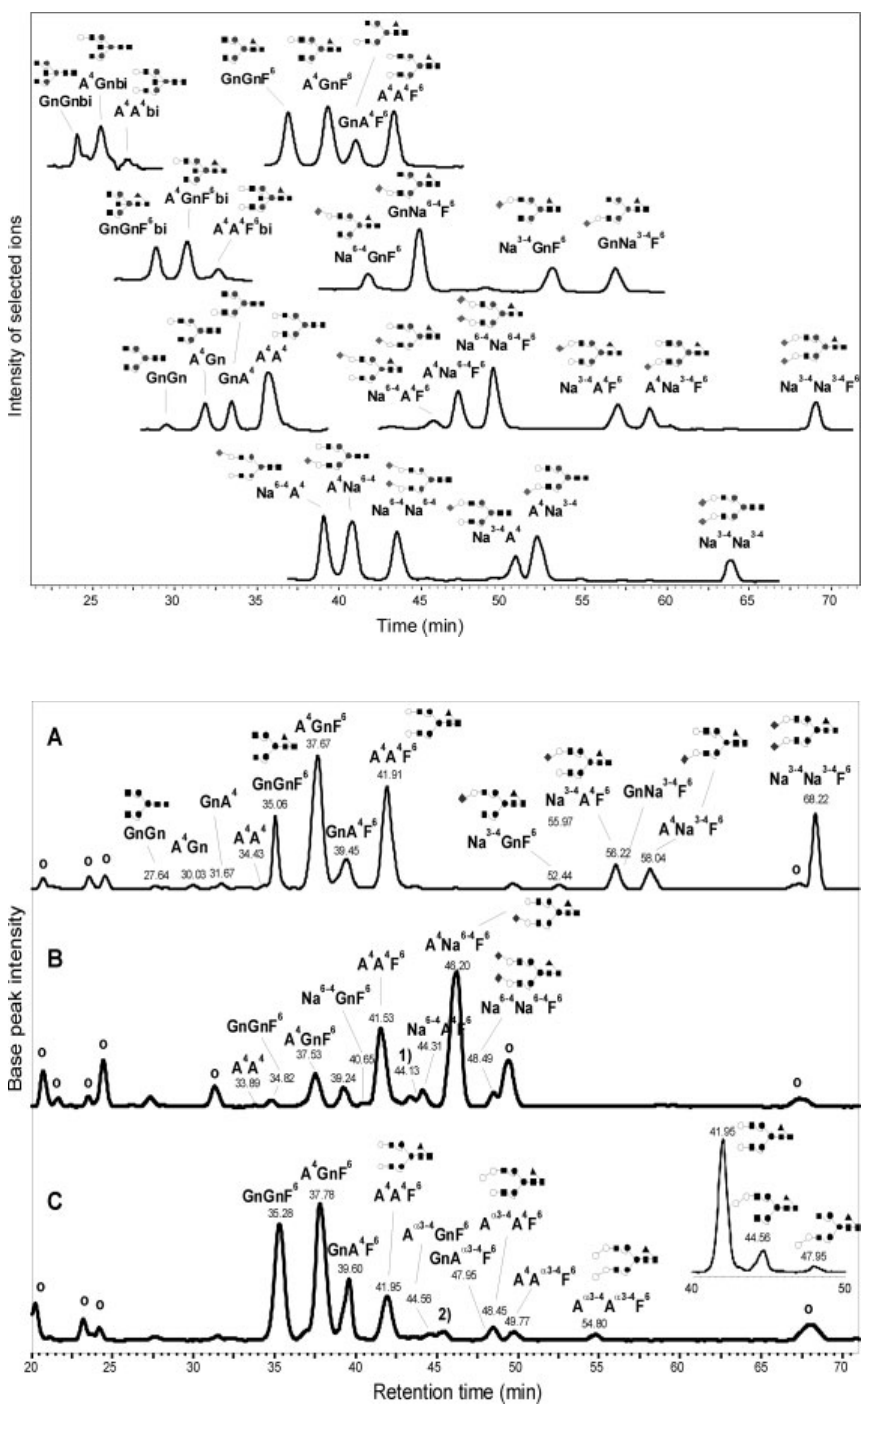
Figure 7. PGCC-ESI-MS of refer- ence oligosaccharides. The elu- tion order of reduced reference oligosaccharides was obtained from a single chromatographic experiment. The results are shown in groups comprising the SIM traces of related glycans with two or three different SIM masses, i.e. , the exact masses of the doubly charged ions.